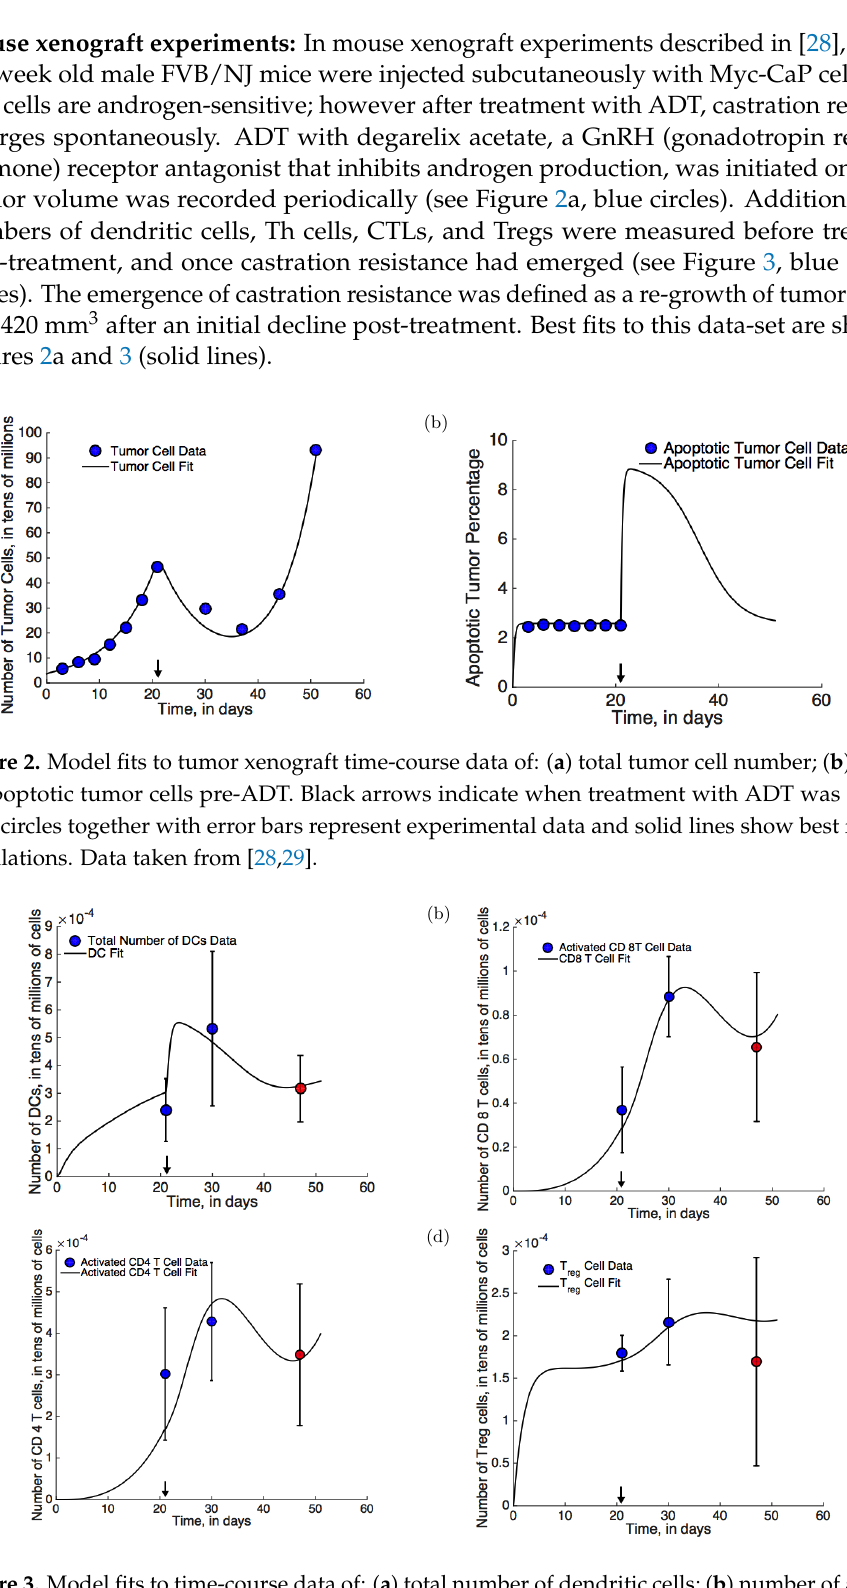
Figure 3. Model fits to time-course data of: ( a ) total number of dendritic cells; ( b ) number of activated CTLs; ( c ) number of activated Th cells; ( d ) number of Tregs. Black arrows indicate when treatment with ADT was initiated, blue/red circles together with error bars represent experimental data and solid lines show best fit model simulations. Data taken from [28]. Red circles represent data reserved for model validation, and were not used in the fitting